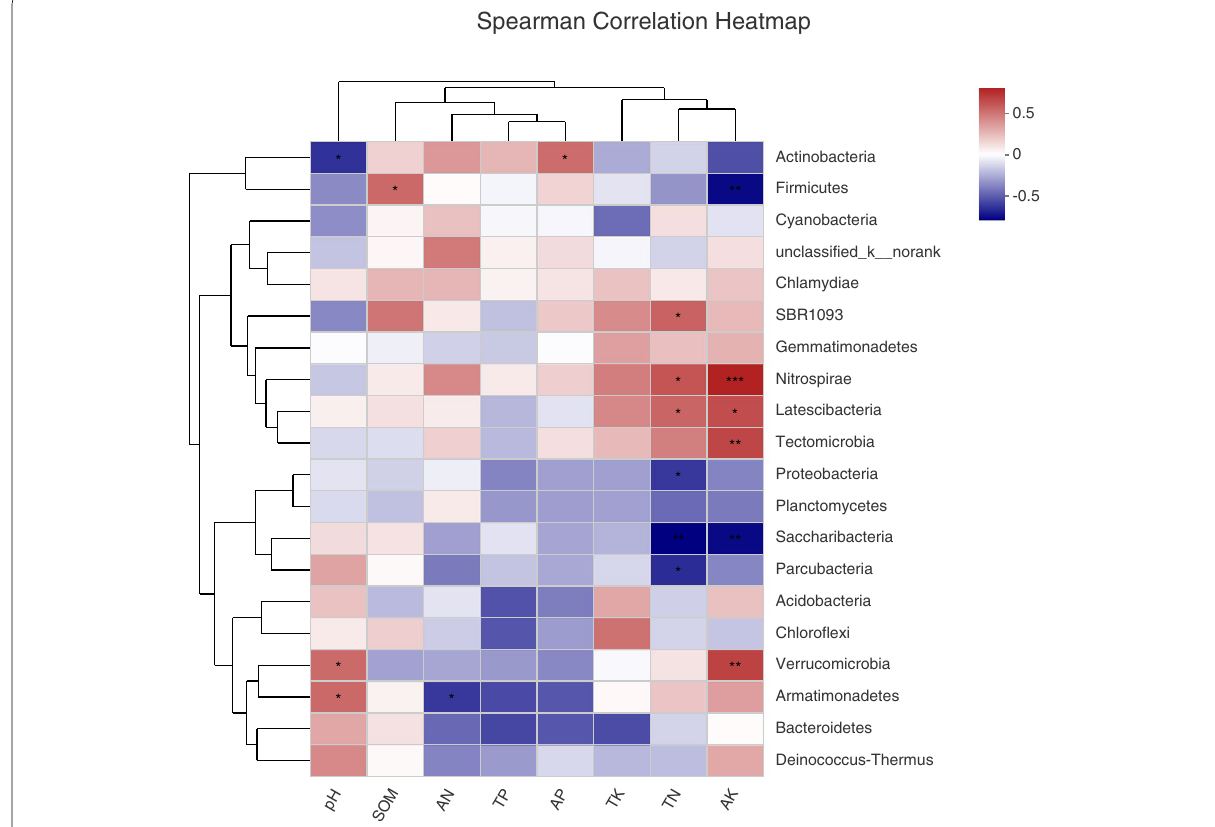
Fig. 5 Correlation heat map of the top twenty phyla and soil